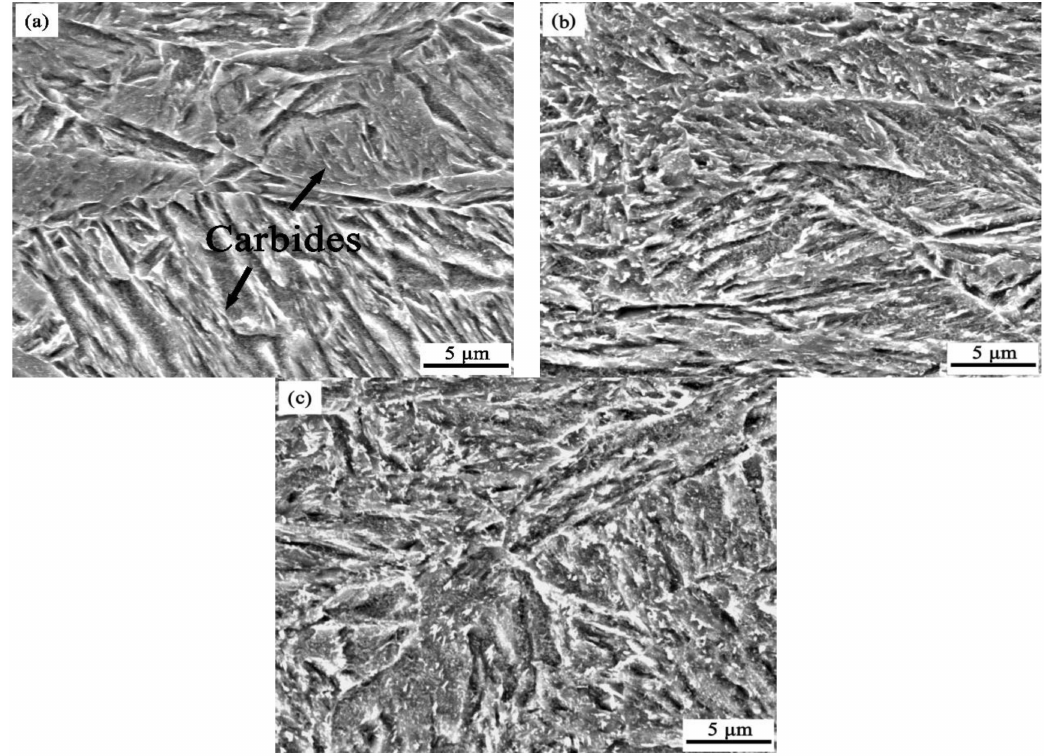
Figure 3. SEM micrographs of ( a ) sample #1, ( b ) sample #2, and ( c ) sample